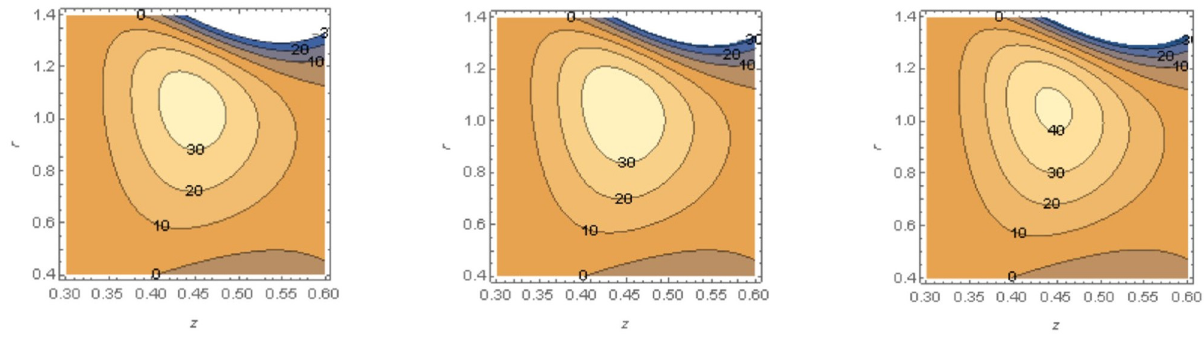
Figure 20: Various values of the wave frame streamlines of Q 2 = { 0.5, 0.6, 0.7 } at W